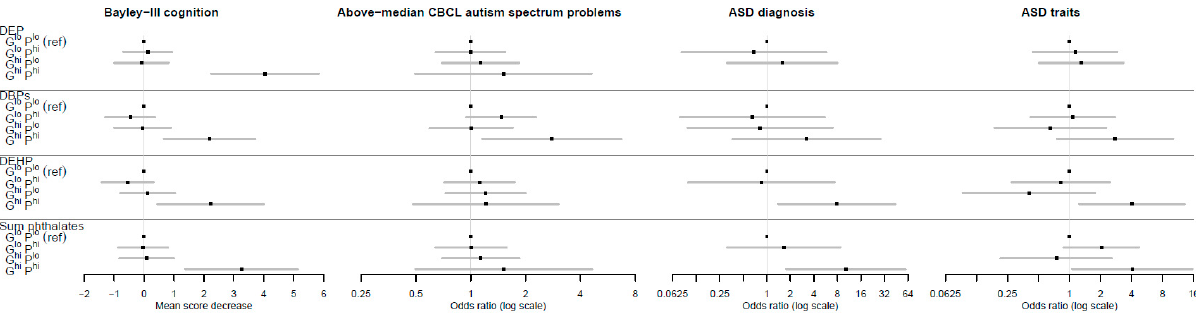
Figure 3. The association between the genetic pathway function score for oxidative stress response (gPFS ox ) and prenatal phthalate level combinations and neurodevelopment. Note: Error bars are 95% confidence intervals; G hi = top quintile of gPFS ox ; G lo = bottom four quintiles of gPFS ox ; P hi = top quintile of phthalate exposure; P lo = bottom four quintiles of phthalate exposure; DEP = diethyl phthalate; DBPs = di-n-butyl phthalate (DnBP) + diisobutyl phthalate (DiBP); DEHP = di-(2-ethyl-5- oxohexyl) phthalate; sum phthalates = sum of DEP, DBPs, and DEHP. Table 4. Distributions of neurodevelopmental outcomes by genetic pathway function score for oxidative stress response (gPFS ox ) and prenatal phthalate level combinations. Above-Median CBCL Autism Bayley-III Cognition ASD Diagnosis ASD Spectrum